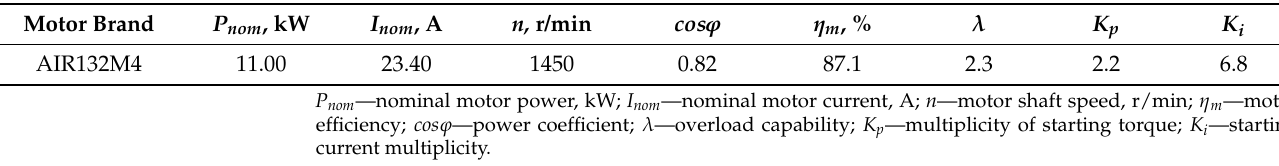
Table 1. Induction motor data